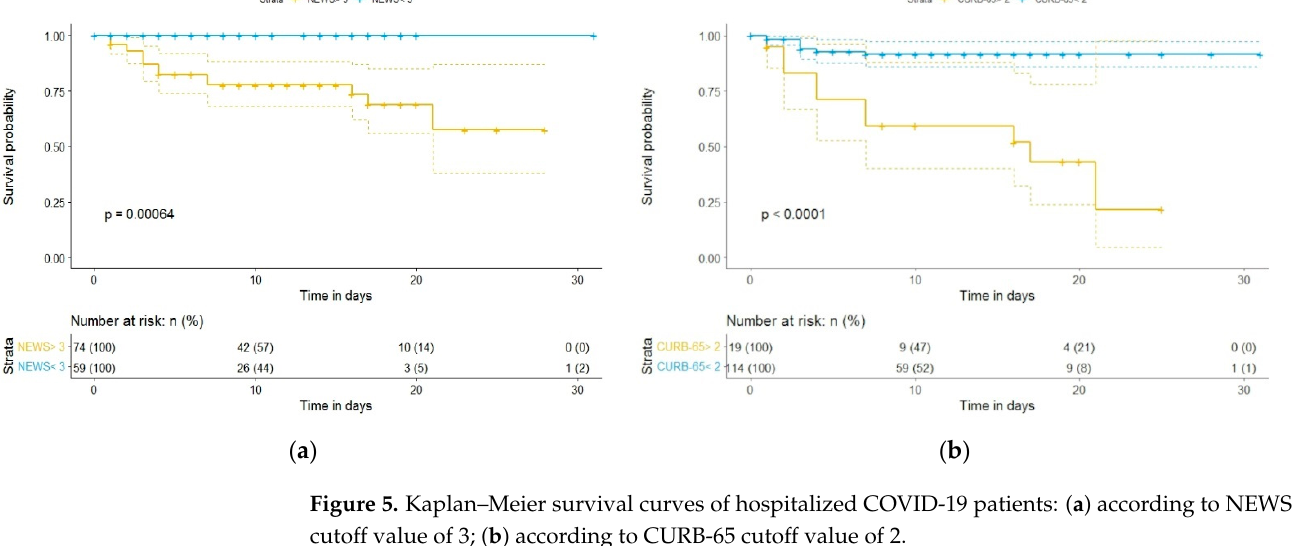
Figure 4. Kaplan–Meier survival curves of hospitalized COVID-19 patients according to 4C Mor- tality Score risk.